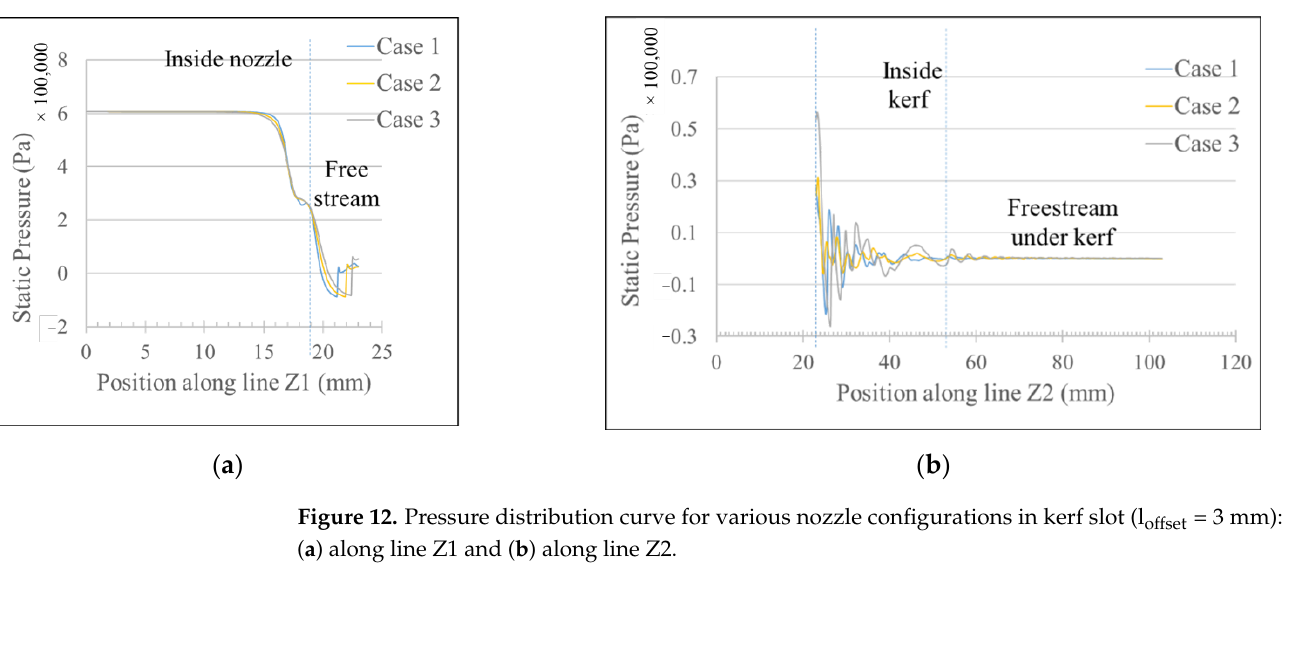
( b ) Figure 13. Pressure distribution curve for various nozzle configurations in kerf slot (l offset = 6 mm): ( a ) along line Z1 and ( b ) along line Z2. ( a )